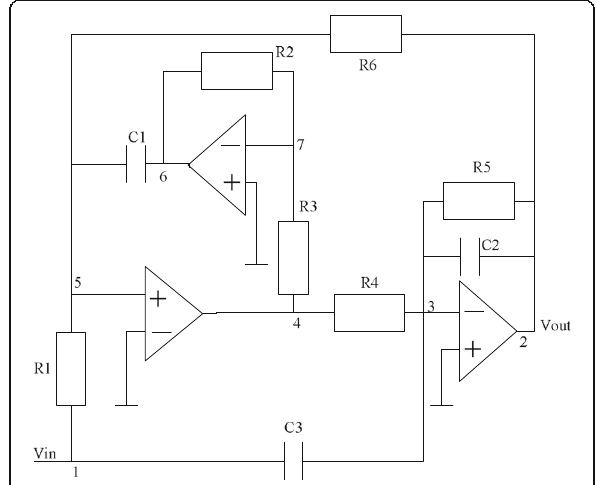
Fig. 11 Åkerberg-Mossberg band-stop filter circuit